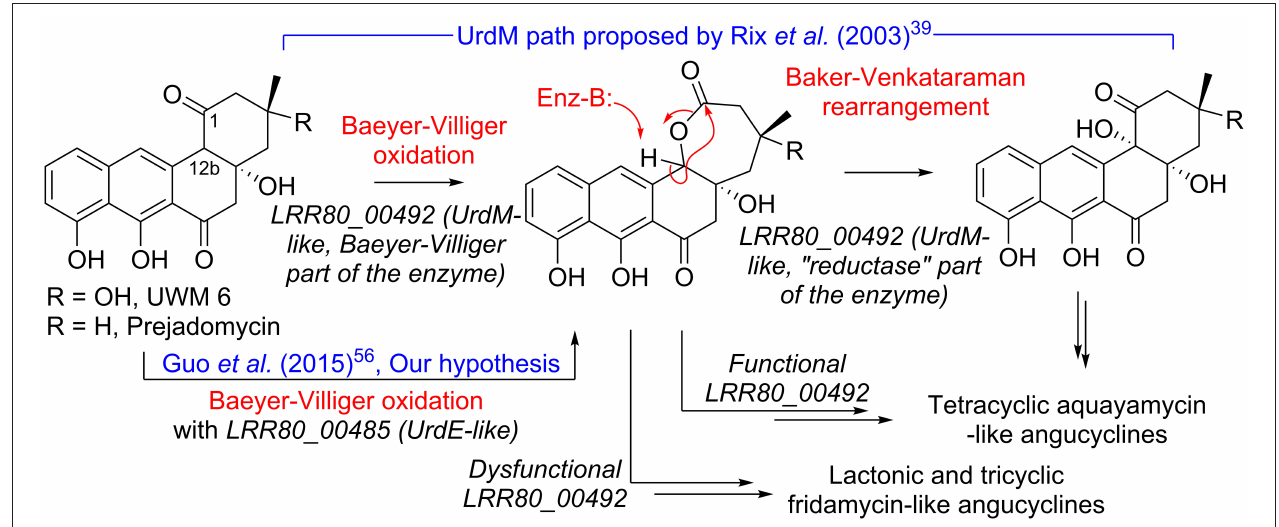
FIGURE 6 | Hypotheses for conversion of UWM 6 or prejadomycin into angucyclines.